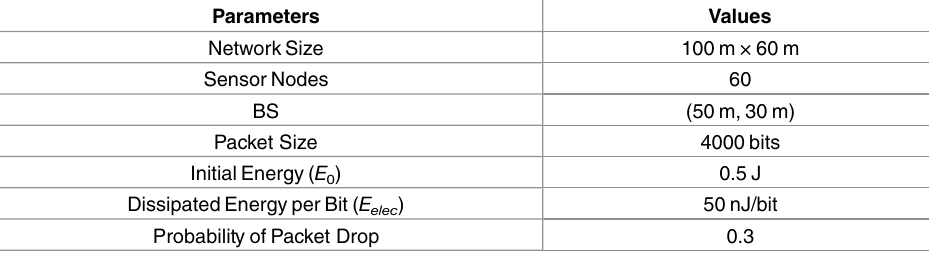
Table 1. Simulationparameters.